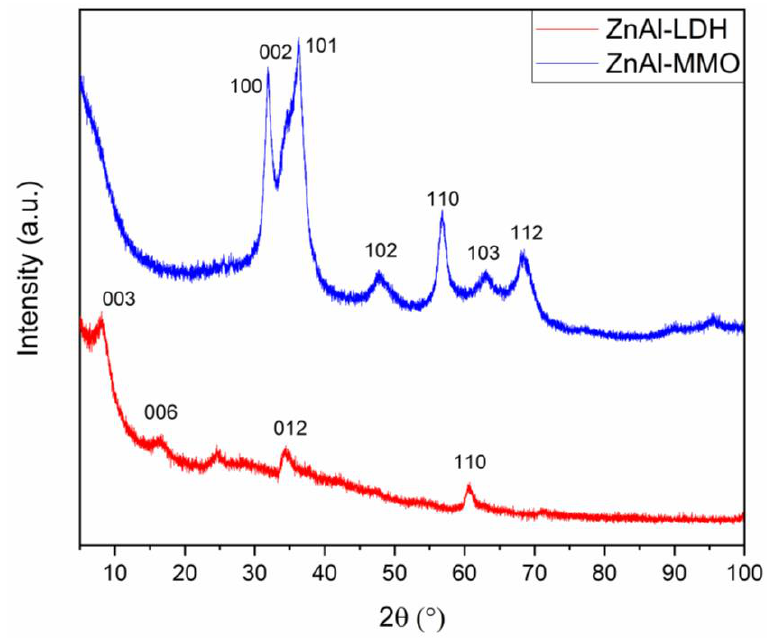
Figure 2. PXRD pattern for the pristine LDH compound (red line) and the ZnAl-MMO (blu line).